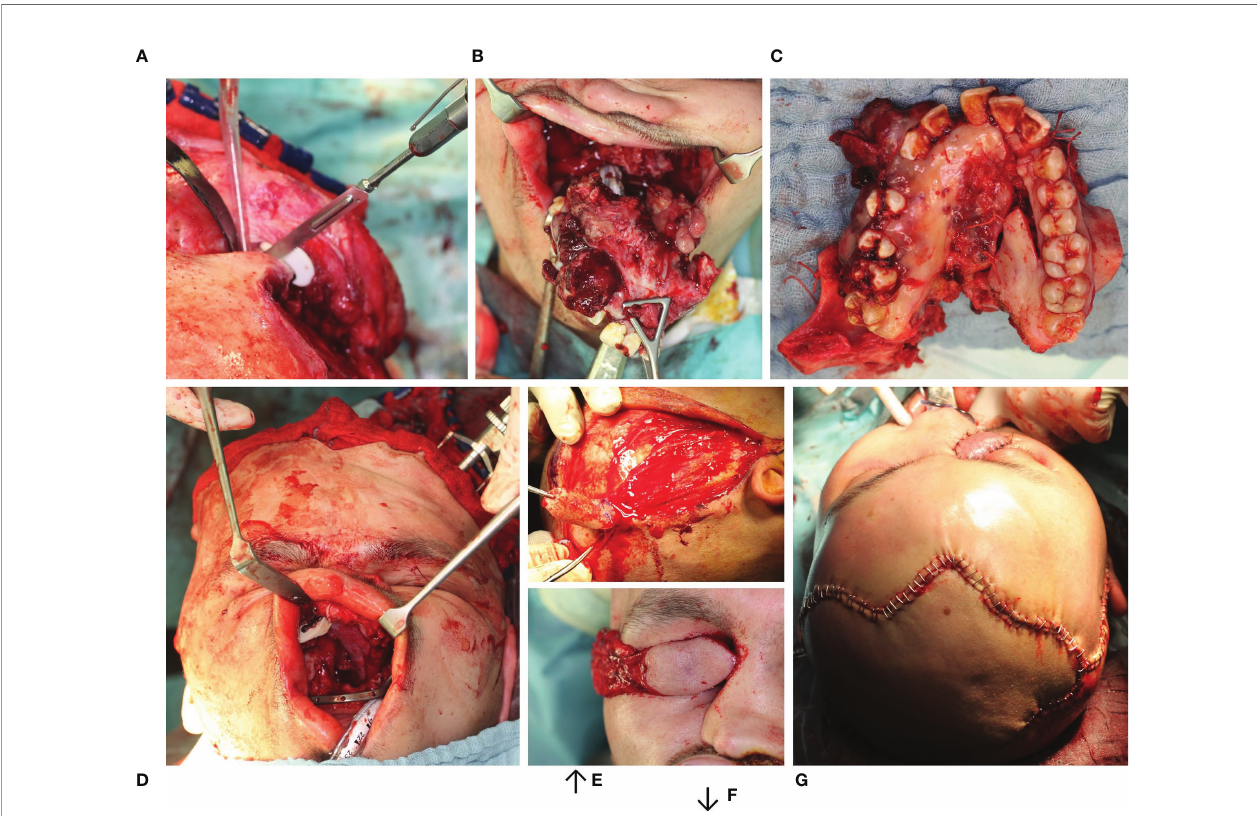
FIGURE 6 | Resection of Ewing ’ s sarcoma of the midface with primarily functional reconstruction. (A) Bone resection using a cutting guide. (B, C) Tumor resection en bloc preserving the eyeball. (D) Primarily functional reconstruction reconstruction of the zygomatic bone and orbit fl oor using two patient speci fi c implants (combined SLM titanium and PEEK (KLS Martin ® , Tuttlingen) using the virtually mirrored left orbit as a template) both visible intraorally. (E, F) Dissection of the temporal muscle fl ap. (G) Wound closure with temporal muscle fl ap sewn